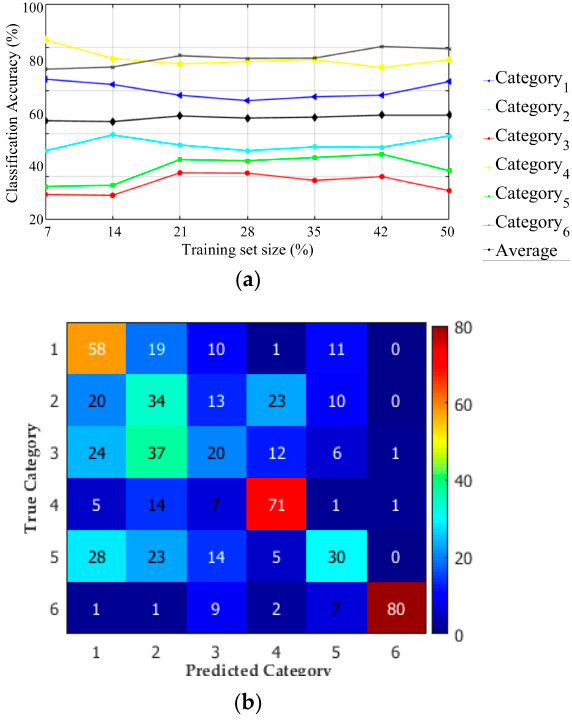
Figure 22. The topographies classification performance of multiscale LP data set: ( a ) the effect of increasing the training set size on the classification accuracy and ( b ) a confusion matrix for six surface category classifications by using 42% of the LP data set for training.